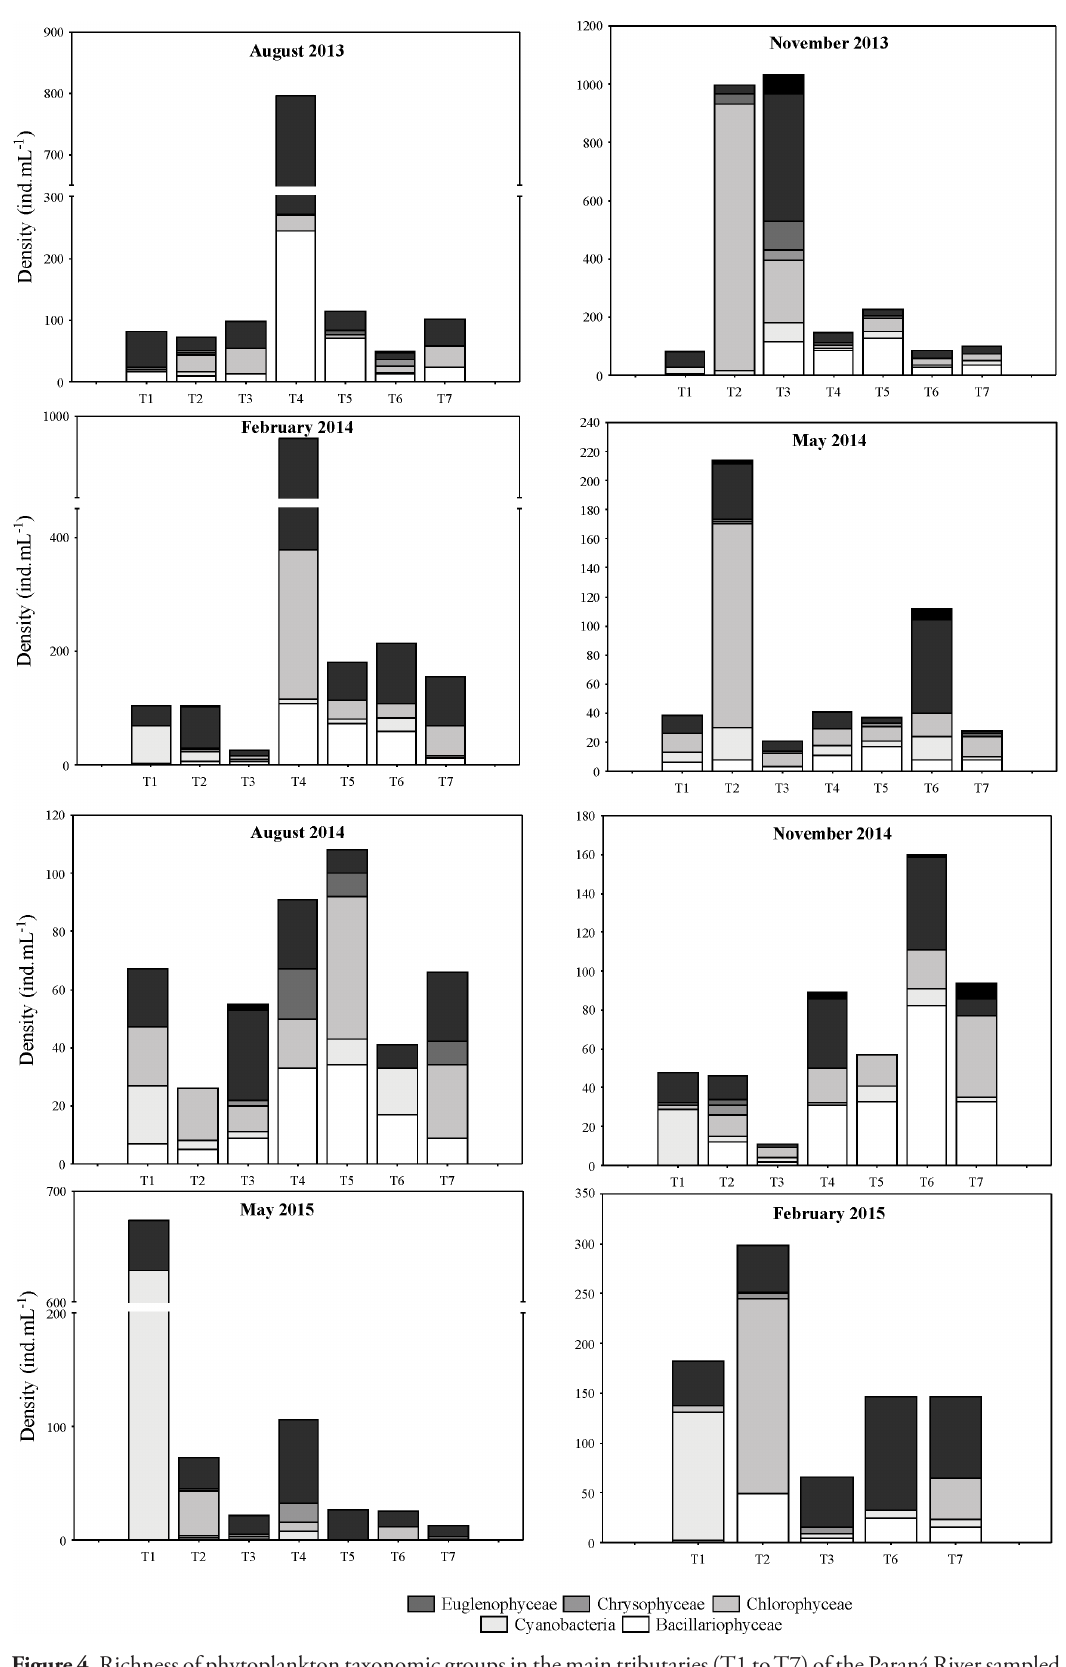
Figure 4. Richness of phytoplankton taxonomic groups in the main tributaries (T1 to T7) of the Paraná River